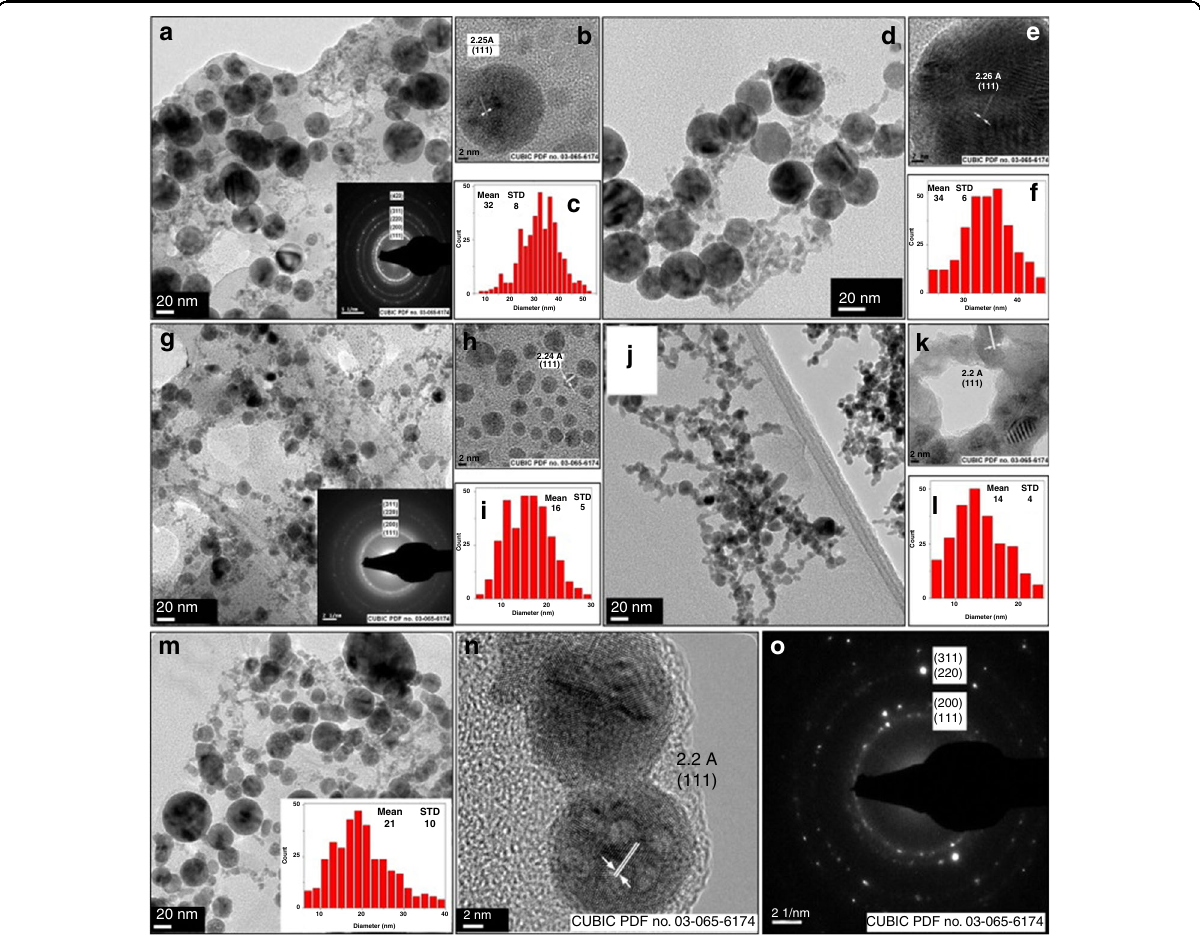
Fig. 11 HR-TEM images of PLAL-synthesized Pd-NPs after post-laser irradiation and sonication. a – f DI water, g – l methanol – DI water mixture, m – o 1 mM SDS. The insets represent their corresponding particle size distributions 54 . Copyright (2021)